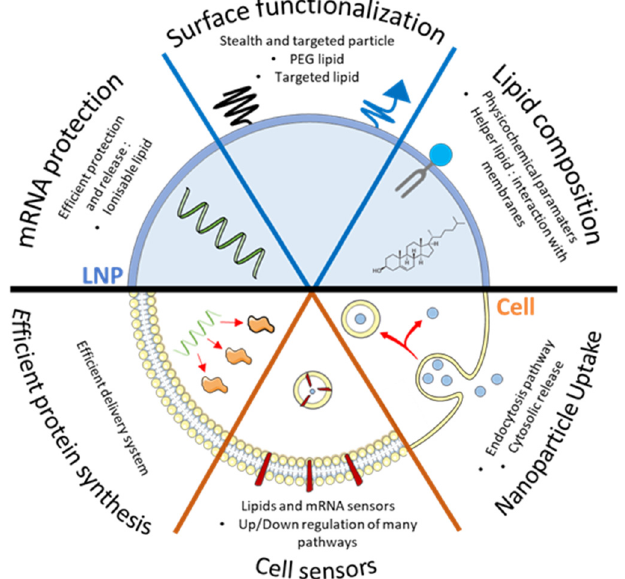
Figure 1. Critical parameter to consider regarding LNPs formulation and cellular interactions. To perform efficient transfection, LNPs should protect mRNA with ionizable lipid until its final desti- nation and should be able to release it efficiently. Surface functionalization through incorporation of targeted lipid will help to reach specific organ/cells while PEGylated lipid will help the circulation of particles in vivo. Finally, incorporation of helper lipids will help either the formation of LNPs or its interaction with biological membrane. Altogether, those lipids need to trigger an efficient cellular uptake of the particle, which leads to the cytosol and avoids the lysosome, without triggering dele- terious cell sensors, so that mRNA can lead to an efficient protein production in the